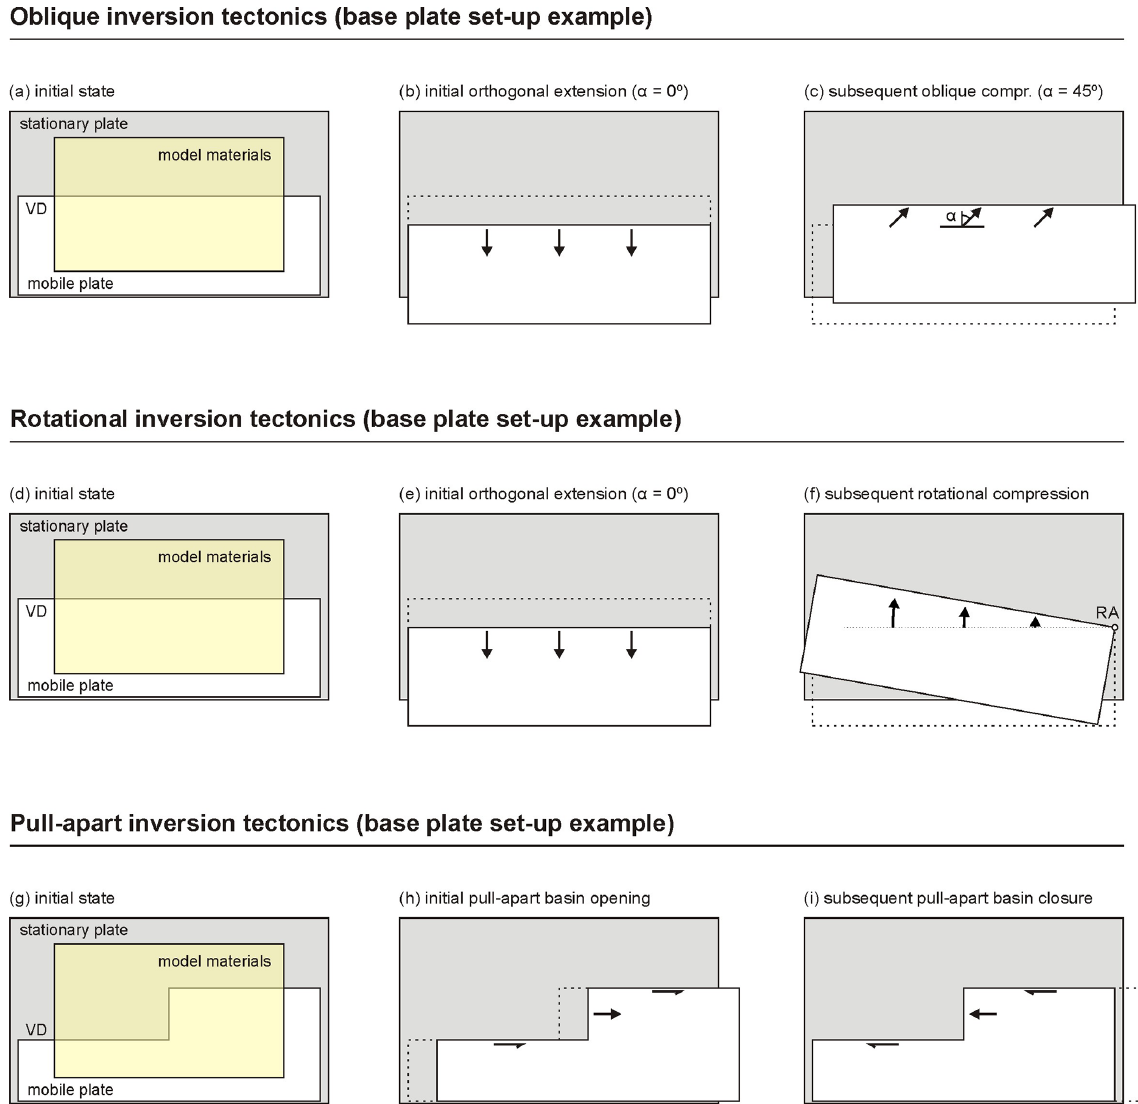
Figure 6. Examples of 3D kinematics in basin inversion models. (a–c) Oblique inversion tectonics example based on Brun and Nalpas (1996). The plate motion direction is defined as angle α , the angle between the normal to the model axis and plate motion direction (e.g. Zwaan et al., 2016; Brune et al., 2018, and references therein). VD stands for velocity discontinuity (mobile base plate edge). (d–f) Rotational inversion tectonics example based on Jara et al. (2015, 2018). RA stands for rotation axis. (g–i) Inverted pull-apart basin example based on Wang et al. (2017). Modellers have used a wide variety of other base plate geometries for basin inversion experiments (see Sect.